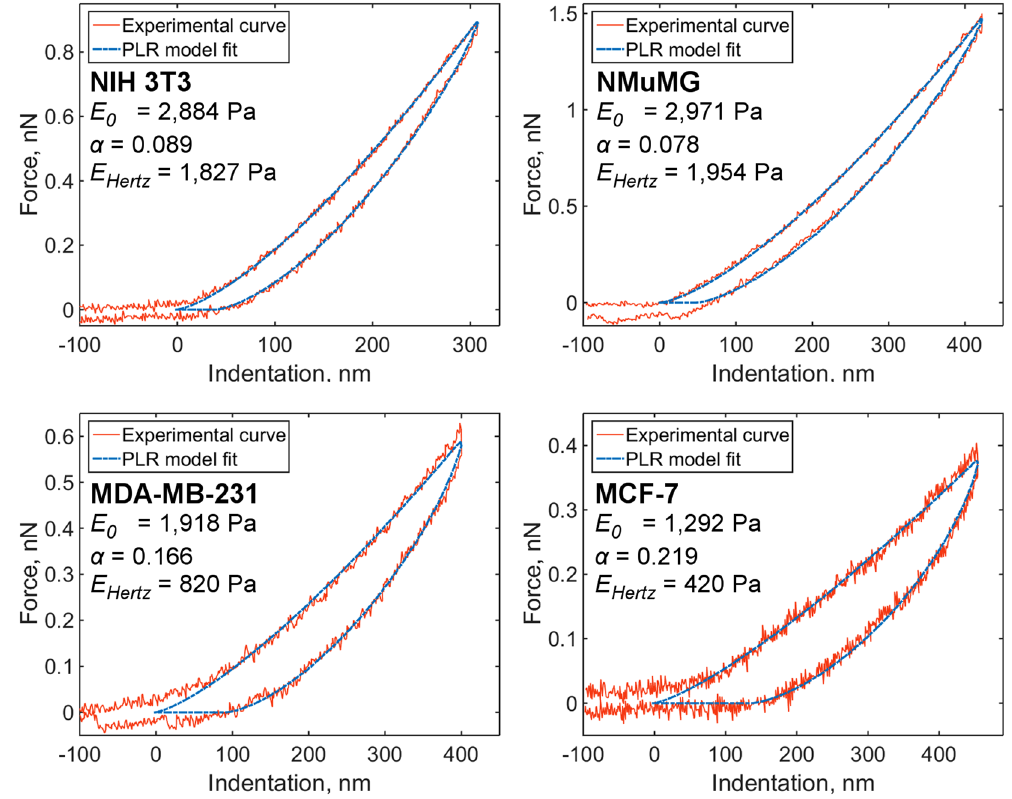
Figure 4. Force curves obtained on different cell lines: NIH 3T3, NMuMG, MDA-MB-231, MCF-7. The fit with PLR model; E Hertz , short-term modulus E 0 and power-law exponent α values are shown.